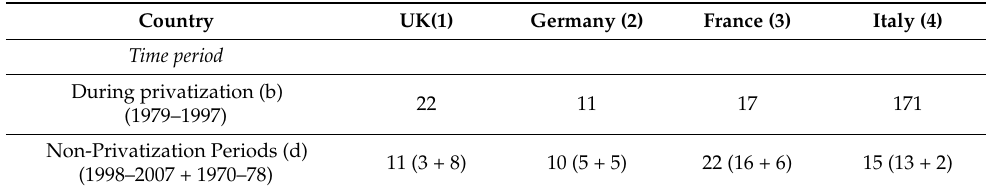
Table A3. Robustness test for Table 3 Total and per Year Number of Multi-fatality Disasters (Excluding Air),